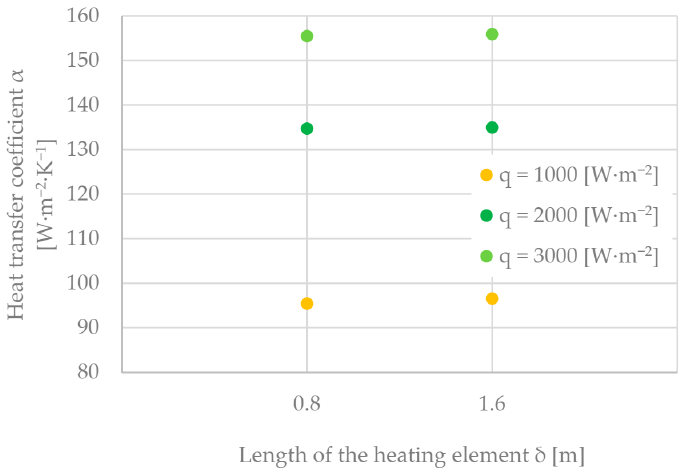
Figure 11. The heat transfer coefficient α depending on the length of the heating element δ for different values of the heat load of the cooled surface q for mineral oil.